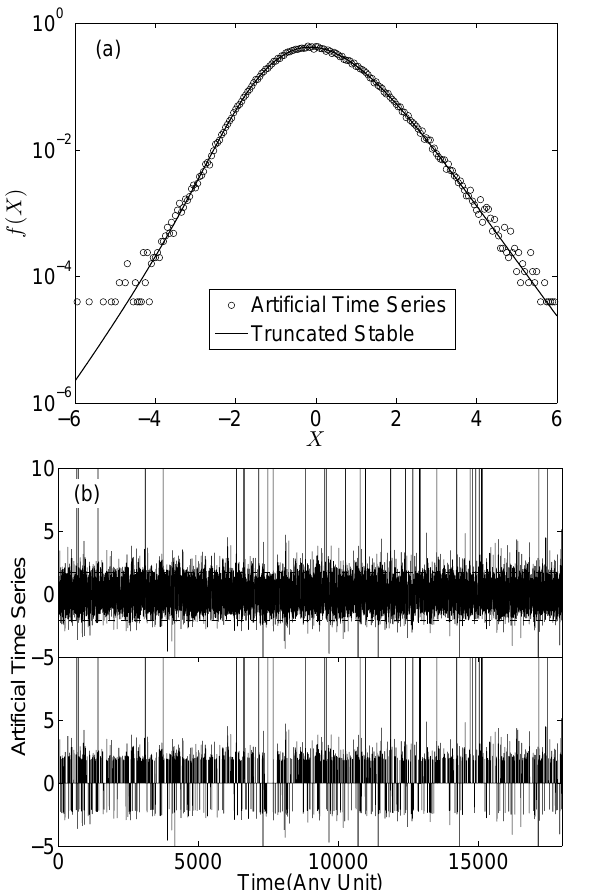
Fig. 7. (a) PDFs of the dimensionless waiting times T w between extreme vertical velocity fluctuations. Points denote the observed PDFs and different symbols represent different stability ranges which are the same as those in Figure 3a. Line denotes the waiting time PDF of artificial time series shown in Figure 7. Dashed line is the fitted stretched exponential distribution and dash-dot line is the exponential distribution with a mean of 1. (b) PDFs of dimension- less waiting times of the surrogate time series which are obtained by randomly sorting the original time series. Line is the exponential distribution with a mean of 1.